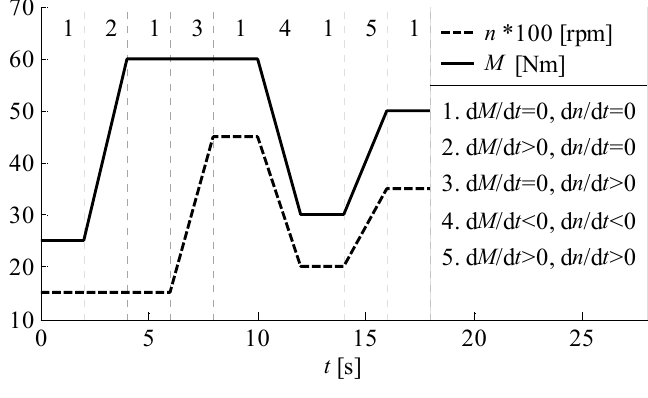
Figure 5. Possible engine working states. 172